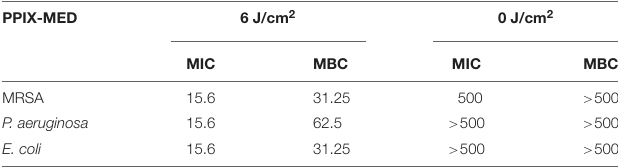
TABLE 1 | Minimum inhibitory concentration (MIC, µ M) and minimum bactericidal concentration (MBC, µ M) of PPIX-MED against methicillin-resistant Staphylococcus aureus , Pseudomonas aeruginosa , and Escherichia coli .